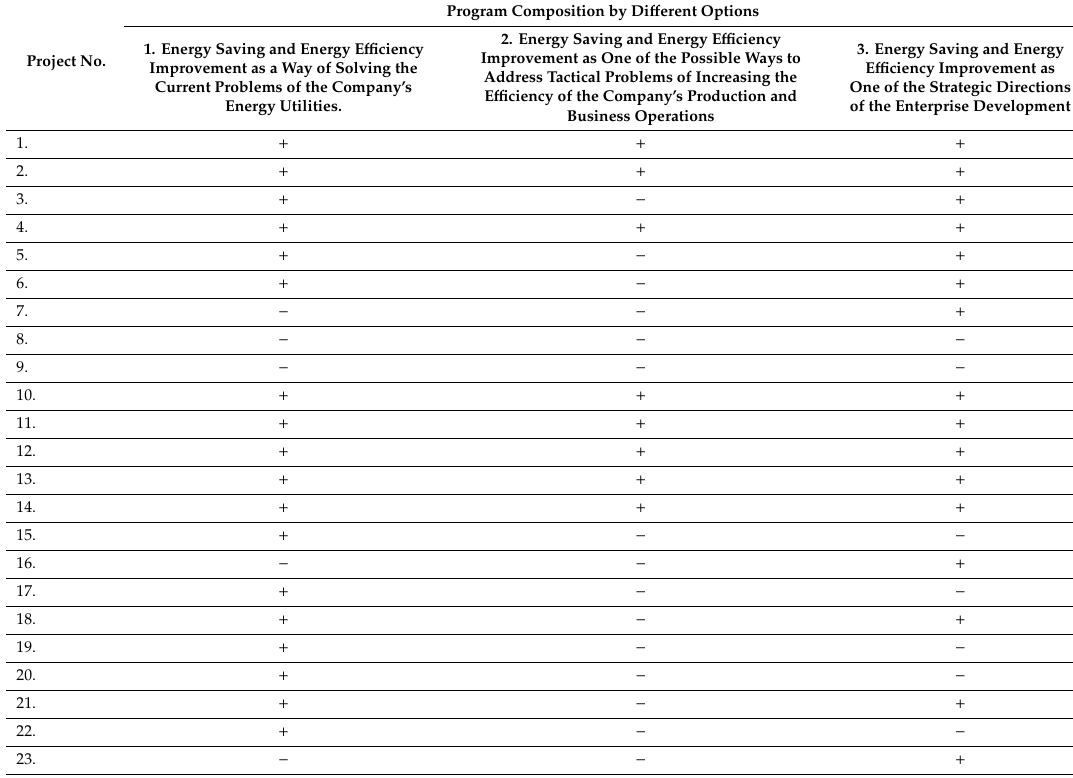
Table 3. The final arrangement of the program’s activities for di ff erent positioning options (source: compiled by the